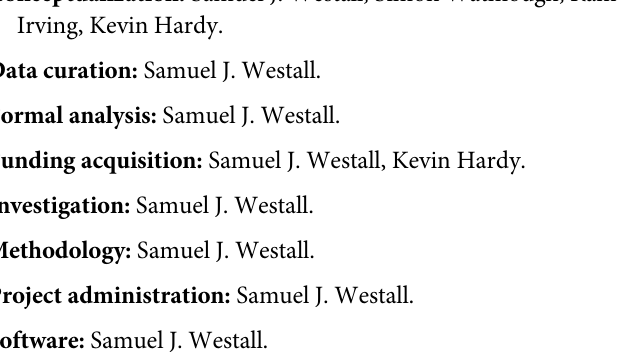
S1 Table. SPIRIT (2013) checklist of standard protocol